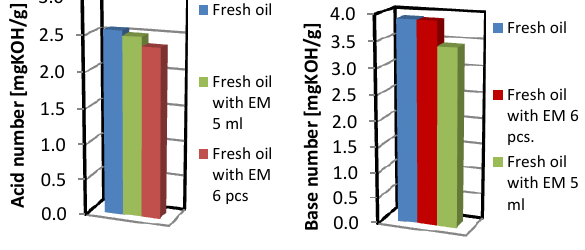
Fig. 8. Acid and base number of fresh oil and fresh oil with EM in liquid form and ceramics